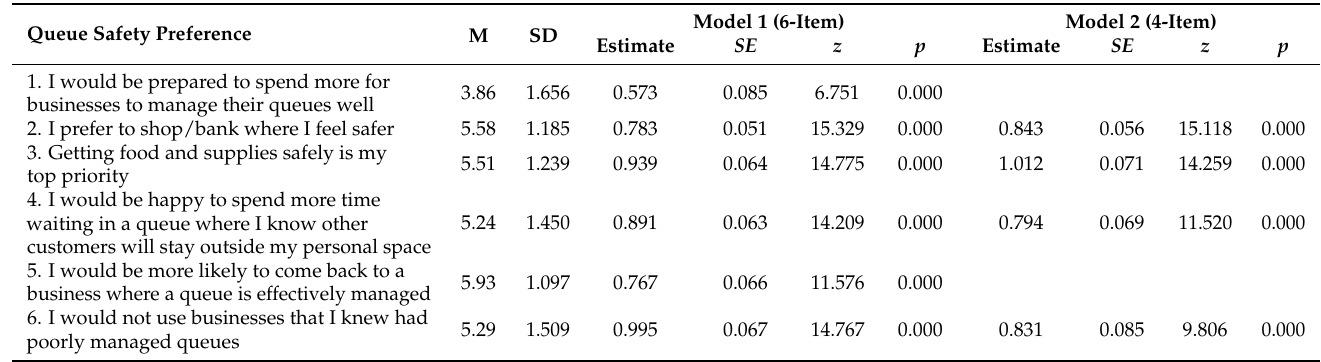
Table 1. Descriptive statistics and estimates from the queue safety preference confirmatory factor analysis.